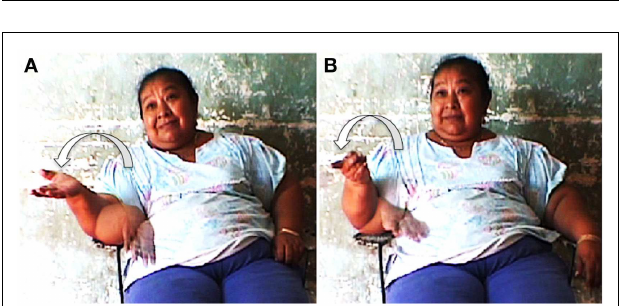
FIGURE 8 | Gestures for (A) sáamal “tomorrow” and (B) ho’olyak “yesterday”